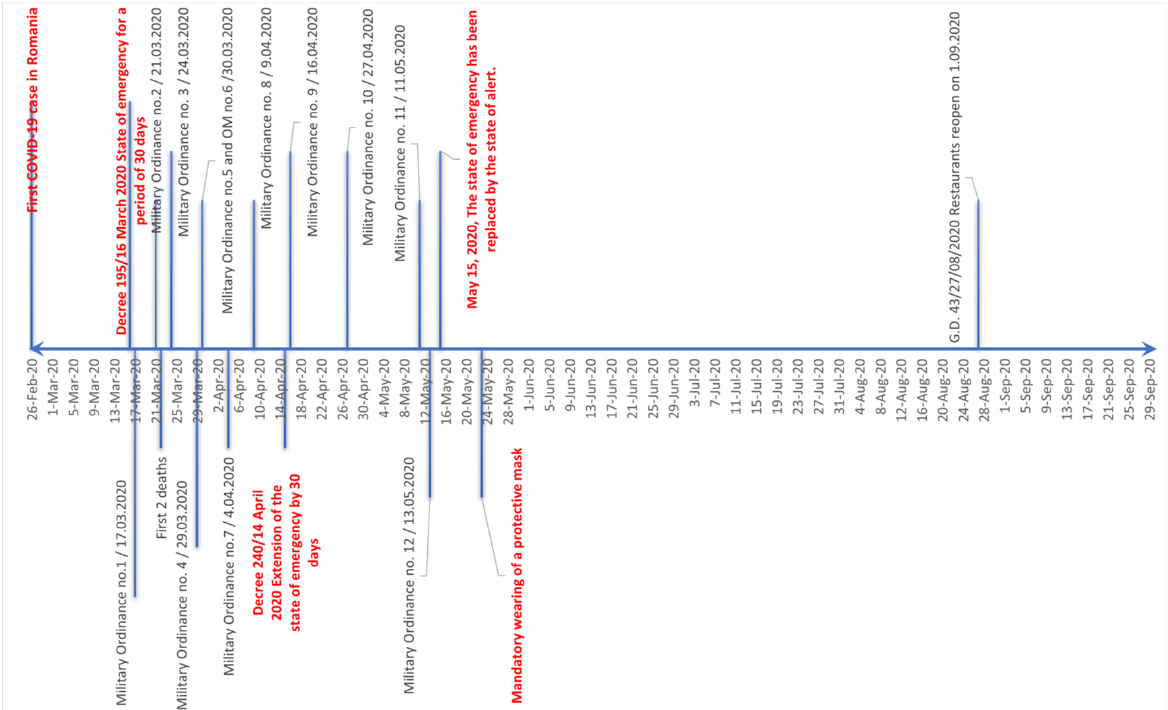
Figure 2. Timeline of COVID-19 2020 outbreak in Romania.